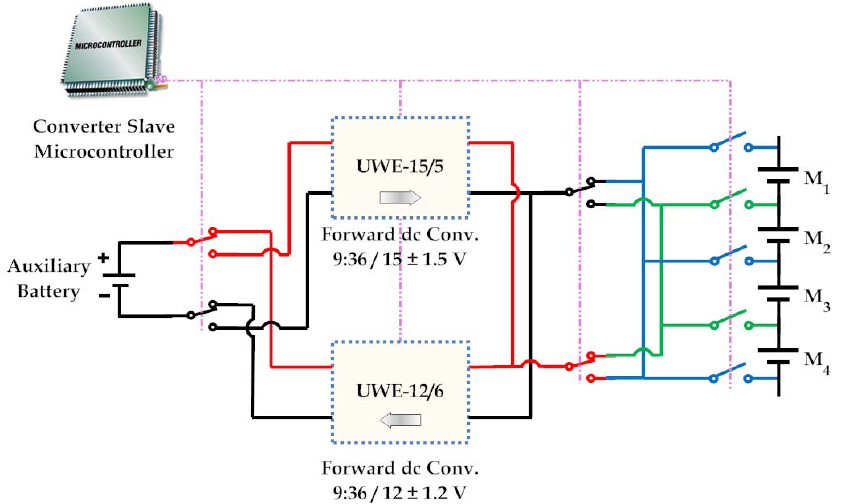
Figure 22. Module balancing (MB) using two forward DC